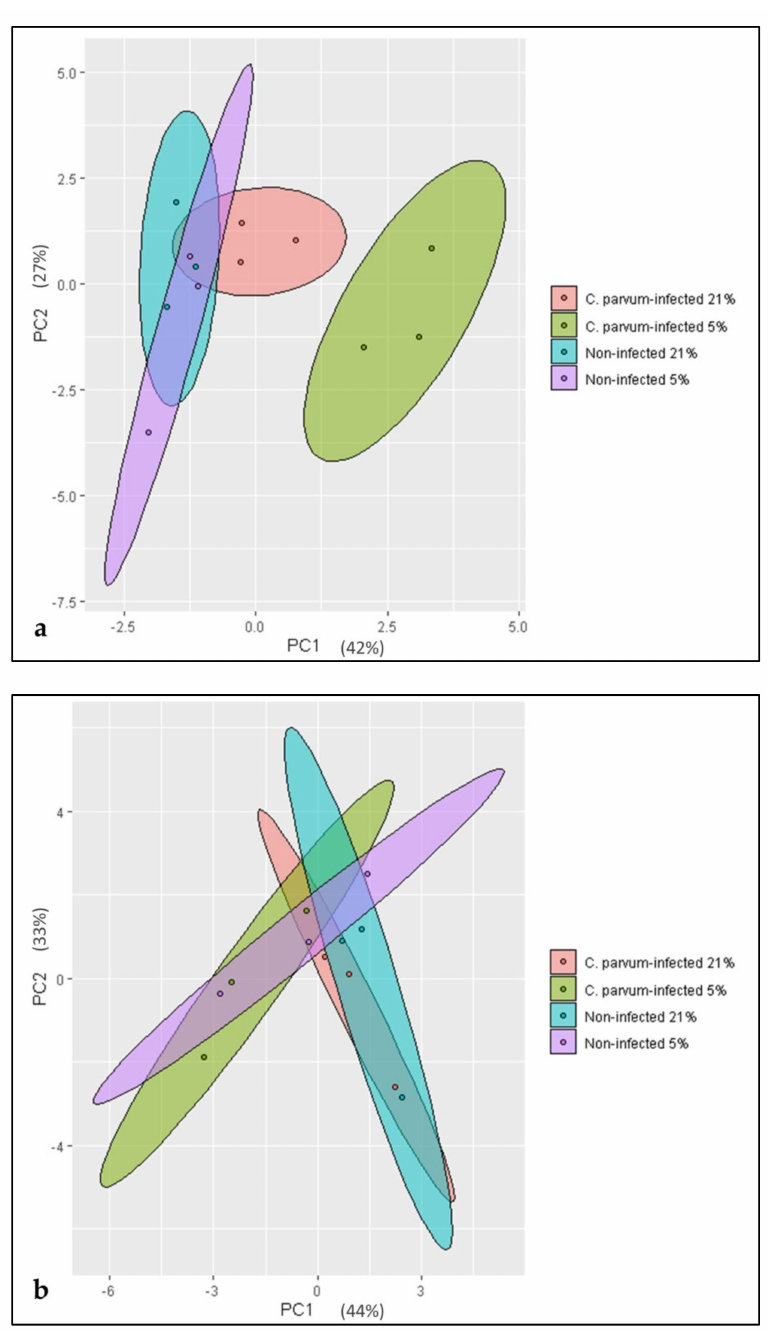
Figure 4. Principal component analysis (PCA) of metabolic data of Cryptosporidium parvum -infected and non-infected bovine small intestinal (BSI) explants under physioxic (5% O 2 ) and hyperoxic (21% O 2 ) conditions at 3 hpi ( a ) and 6 hpi ( b ). The metabolic impact exerted by infection under physioxia was shown to be the major factor contributing to the variability of the dataset at 3 hpi ( a ). In contrast, at 6 hpi, the hyperoxic conditions—independent of infection—tend to explain a greater extent of the variability of metabolic conversion rates ( b